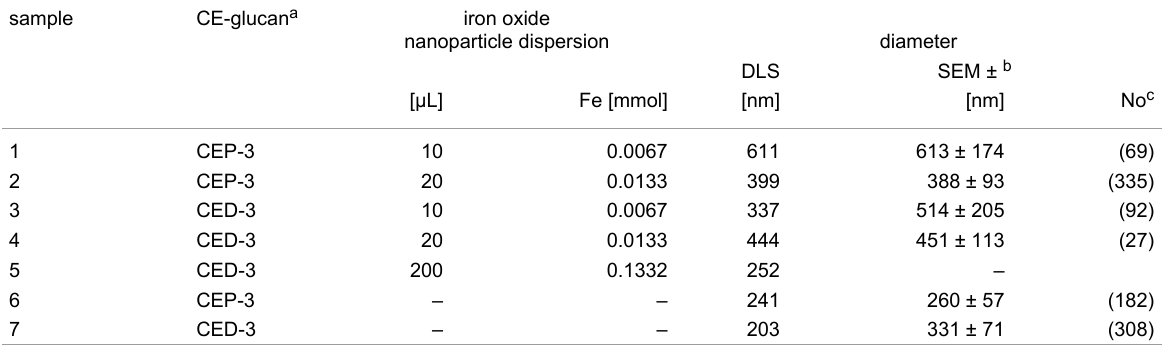
Table 3: Parameters and characterization of nanostructures formed from CED-3 and CEP-3, in the absence and presence of ferromagnetic nanoparti- cles, by DLS and SEM measurements; 20 mg of cyanoethylglucan was used for each entry (= 0.07 mmol glucosyl units). sample